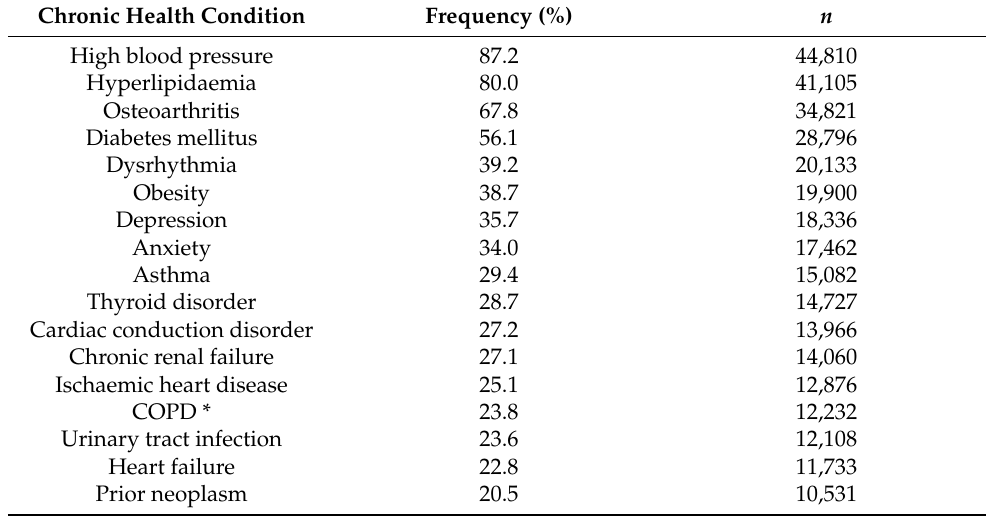
Table 1. Prevalence of health conditions in highly complex chronic